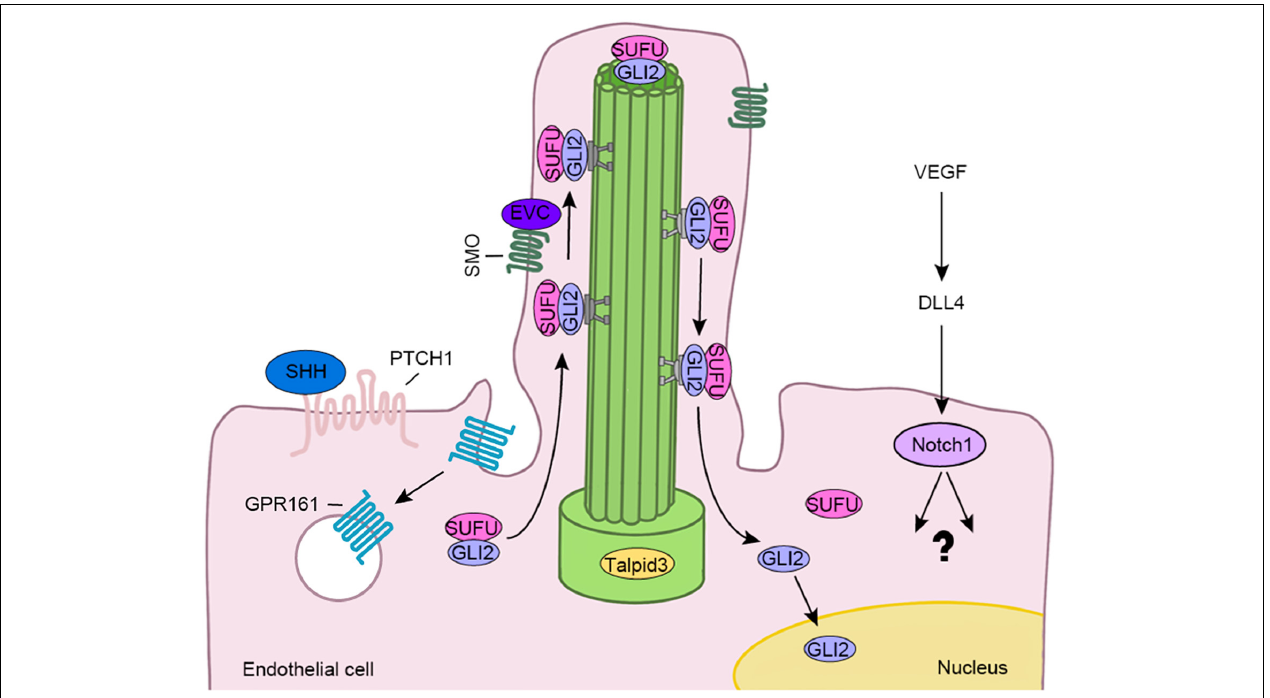
FIGURE 2 | The endothelial cilium regulates various signaling pathways involved in the vascular barrier, such as HH and Notch pathways. The binding of SHH to PTCH1 leads to SMO activation and enrichment at the cilium. GPR161, the negative regulator of the HH pathway, then is internalized from the cilium. Subsequently, the GLI2/SUFU complex is transported to the ciliary tip by the IFT complex. After the complex is dissociated, GLI2 is activated and translocated to the nucleus. In addition, vascular endothelial growth factor (VEGF) induces the expression of delta like canonical Notch ligand 4 (DLL4), which then binds to Notch1 to activate downstream